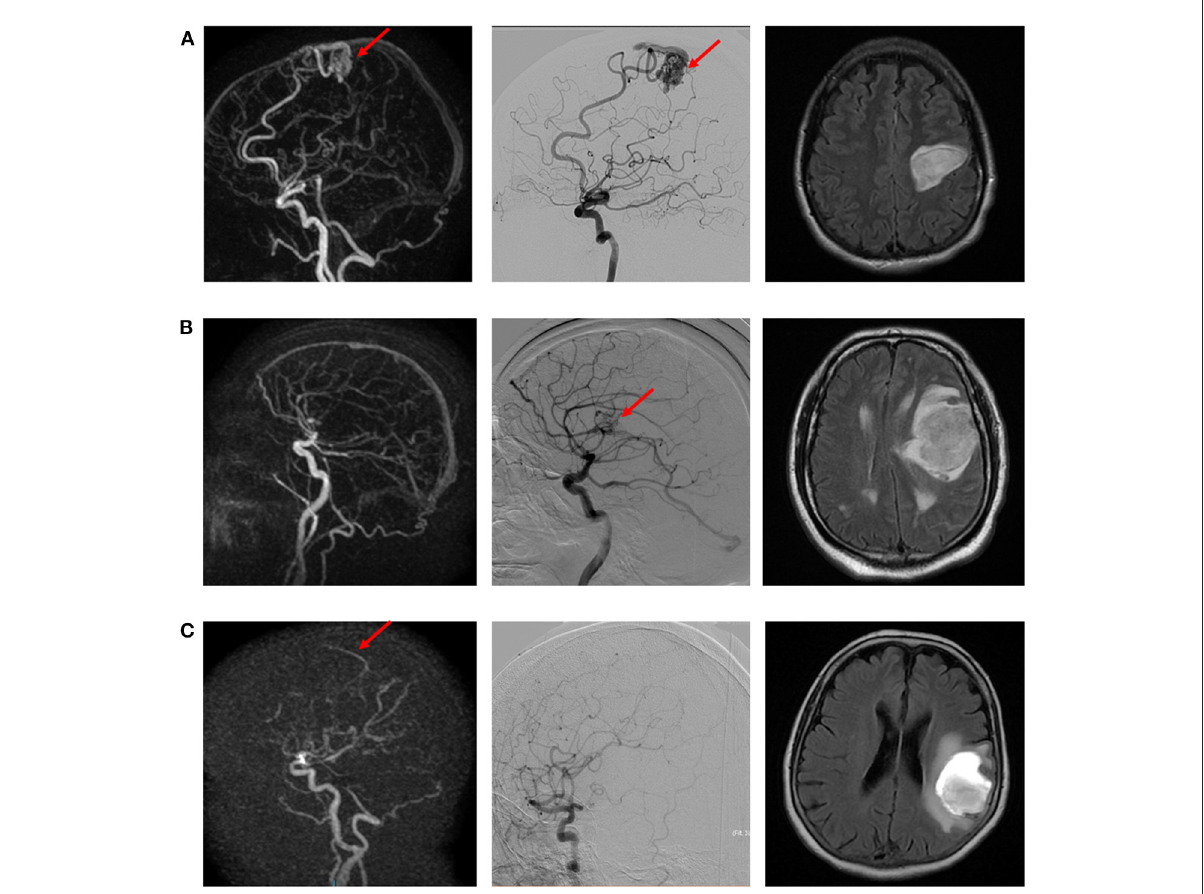
FIGURE1 Illustrative examples of true positive (A) , false negative (B) , and false positive (C) cases of intracranial arteriovenous shunt. (A) Left precentral AVM suspected on dynamic 3D MRA (left) and confirmed with DSA (middle). Morphological MR (right; FLAIR sequence) depicts the ICH. (B) Left opercular AVM diagnosed on DSA (right), not visible on dynamic 3D MRA (left). Morphological MR (right; FLAIR sequence) depicts the ICH. (C) Suspicion of early venous enhancement on dynamic 3D MRA (left), not confirmed on DSA. Morphological MR (right; FLAIR sequence) depicts the ICH.